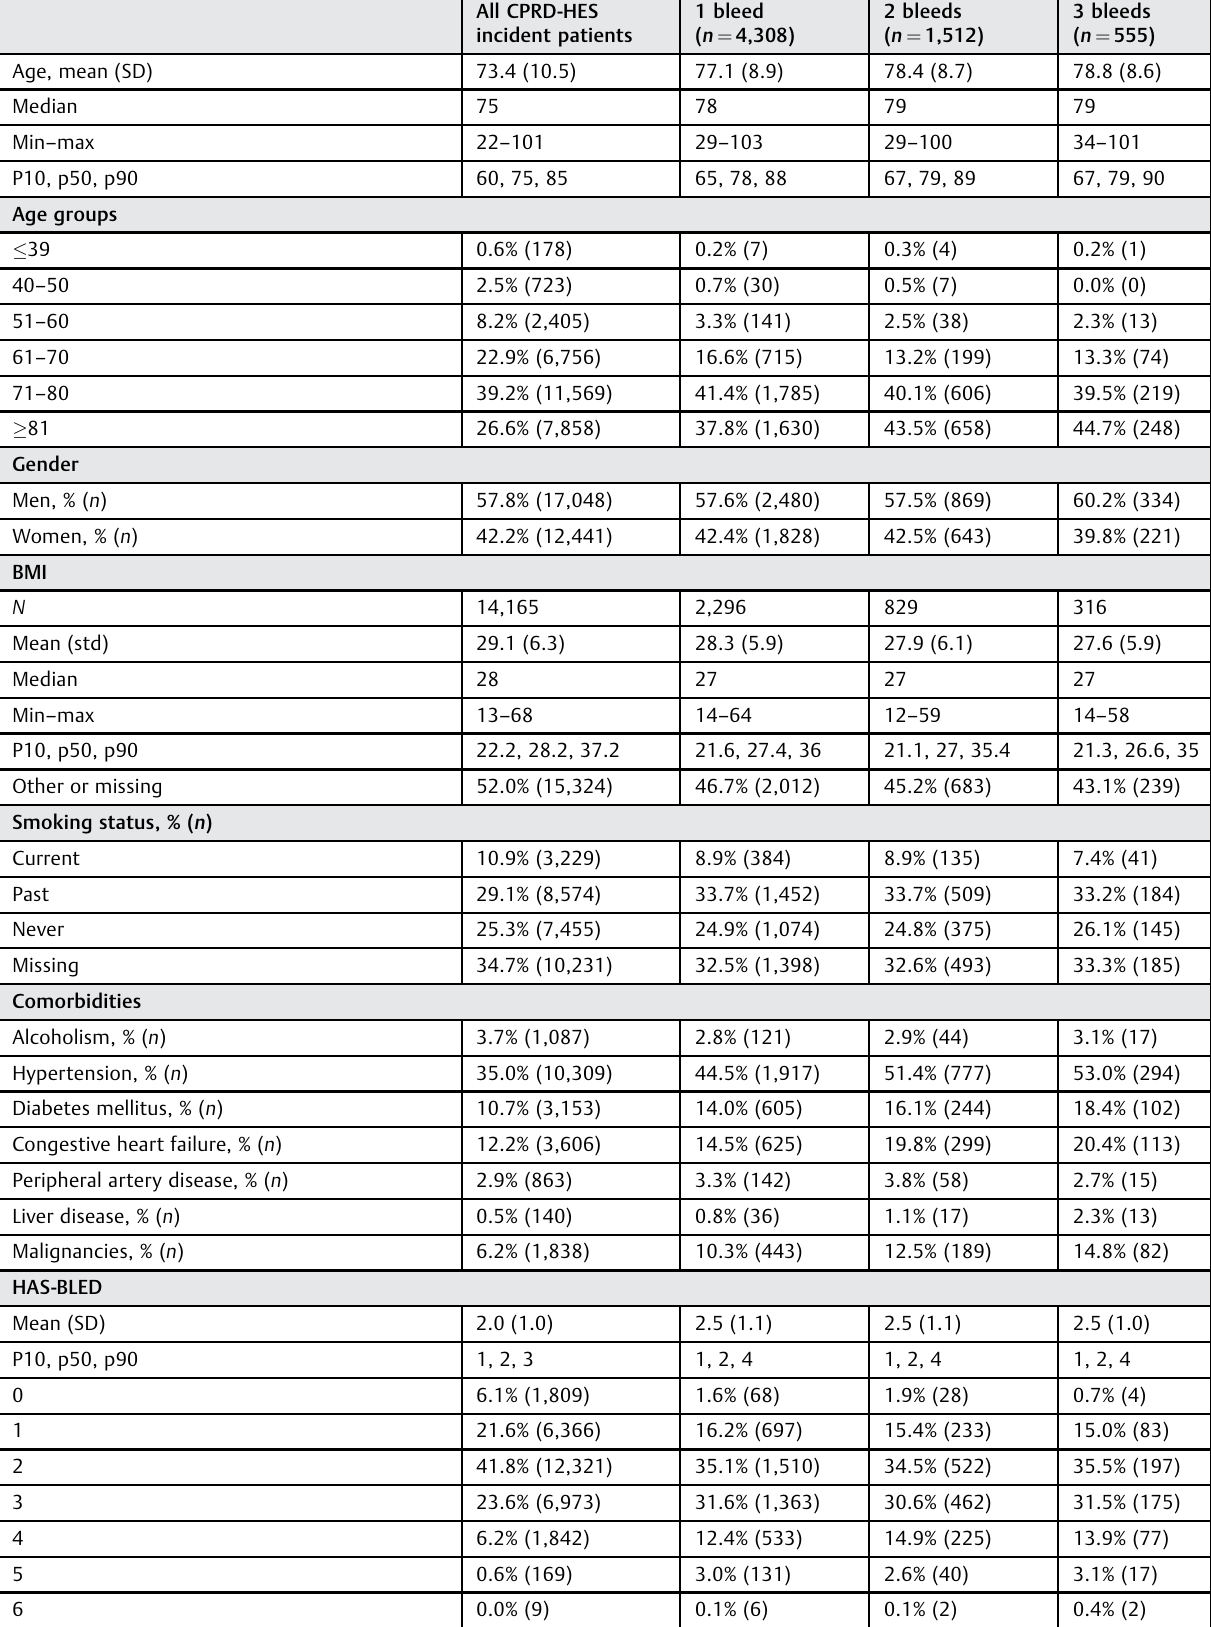
Table 1 Patient characteristics per bleed group (at the time of changing bleed exposure